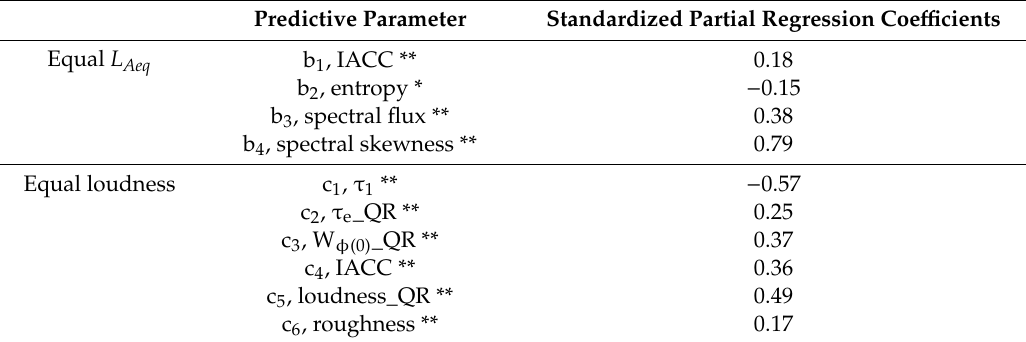
Table 3. Significant predictive parameters and standardized partial regression coe ffi cients revealed by multiple linear regression analyses of birdsong